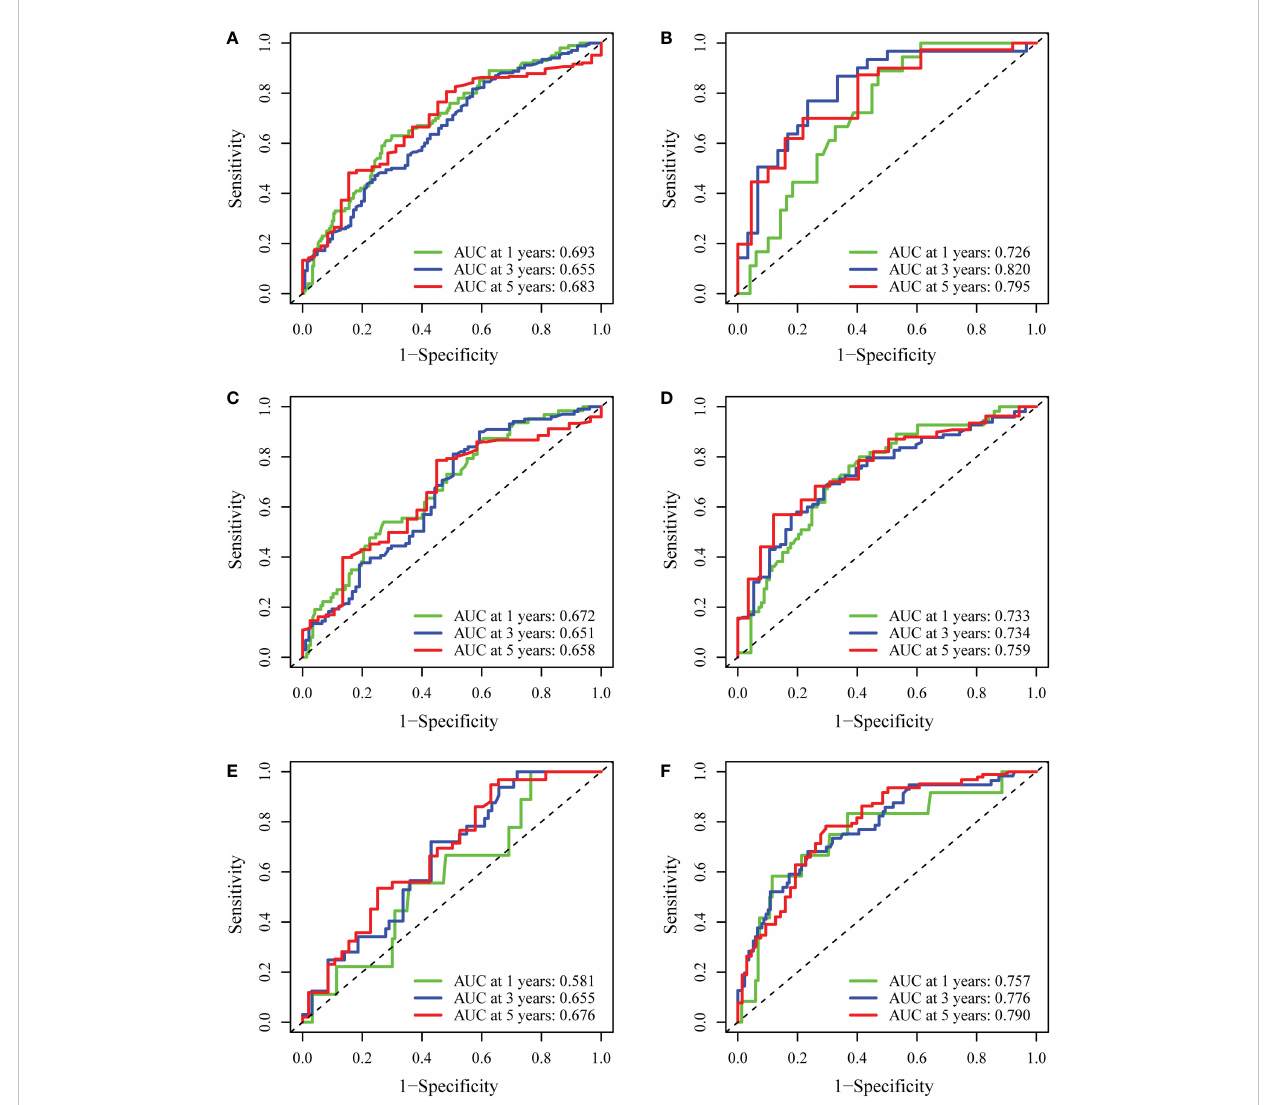
FIGURE 5 Internal validation of the nomogram model. (A, B) The predictive performance of the nomogram based on gender (male vs. female) for RFS. (C, D) The predictive performance of the nomogram based on age (>65 vs. ≤ 65) for RFS. (E, F) The predictive performance of the nomogram based on BMI (normal vs. abnormal) for